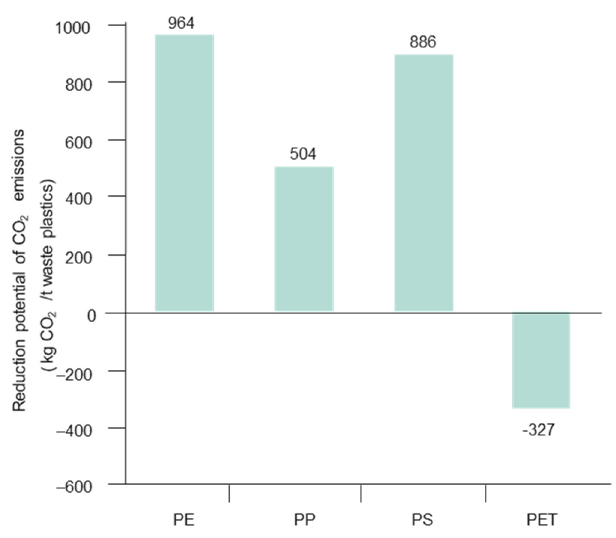
Figure 18. Reduction potential of CO 2 emissions with 1 t waste plastics injection, Adapted from [25], with permission from © 2009 Springer Nature.